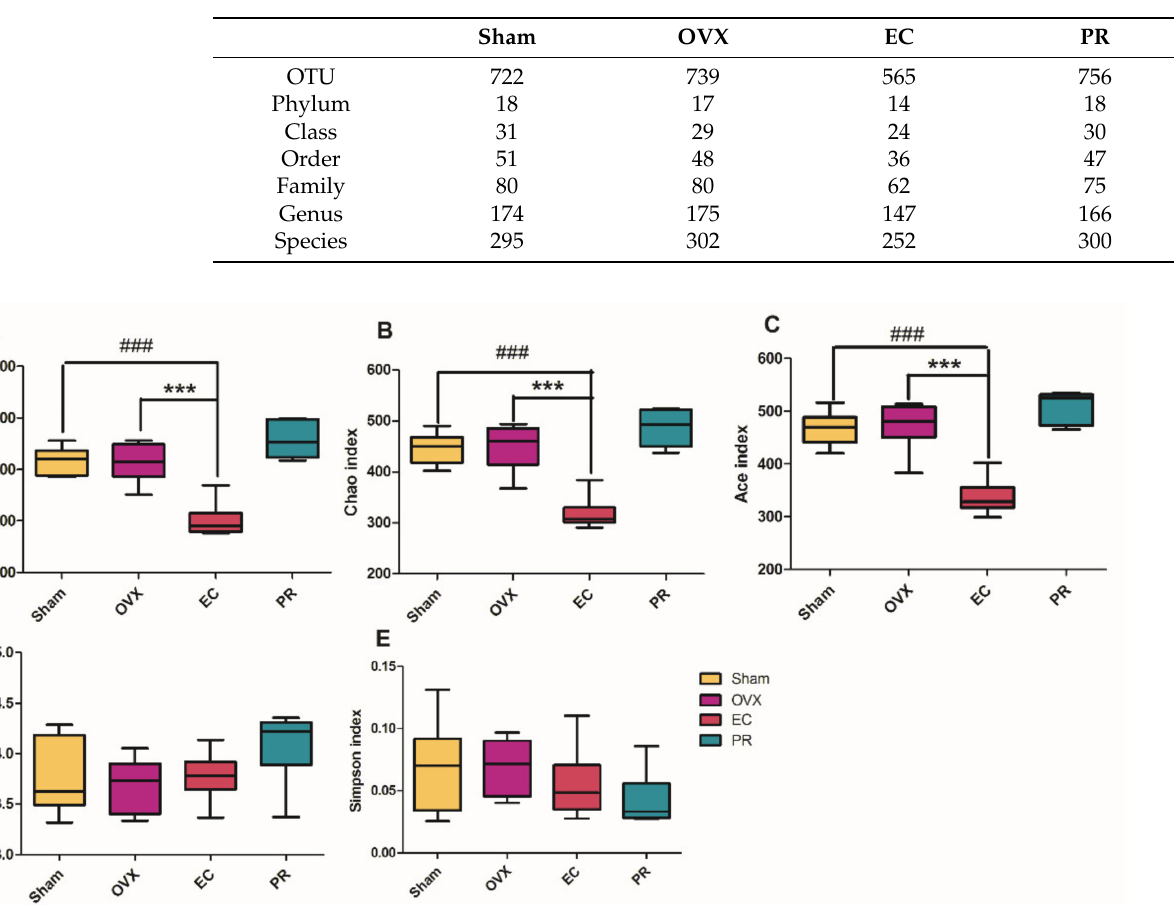
Table 3. Bacterial operational taxonomic unites and taxa in each group at different levels.